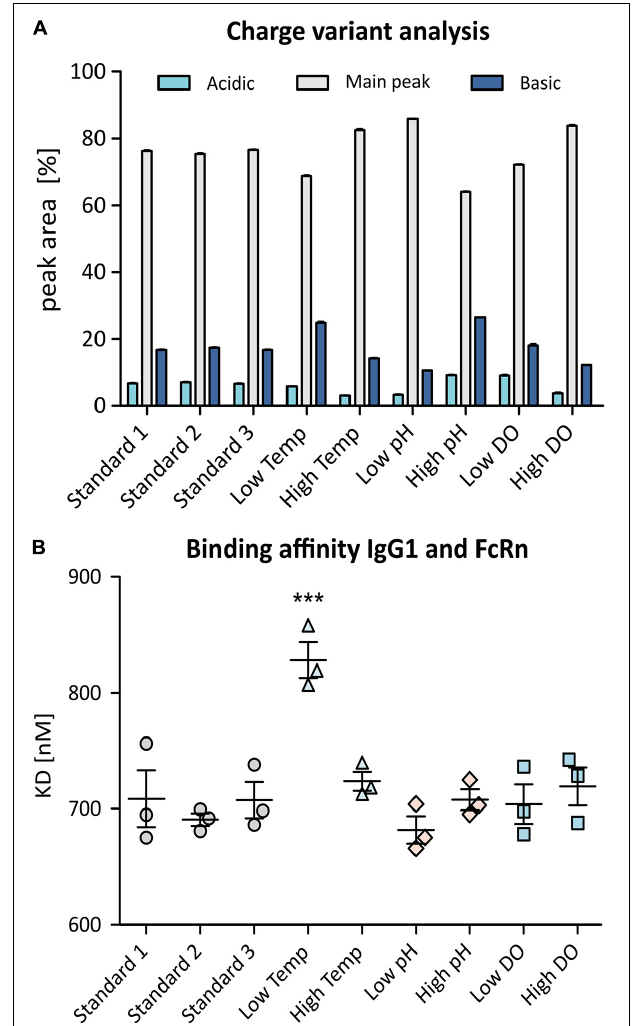
FIGURE 6 | Charge variant analysis (CVA) of produced anti-IL8 IgG1 using SCX-UV (A) . Shown are relative peak areas [%] of the main peak (gray) as well as acidic variants (light blue) and basic variants (dark blue). SPR analysis was used to determine binding affinity of the mAb to recombinant human FcRn (B) . Samples were analyzed in triplicates. Shown are measured dissociation constants (KD). Significance was determined using an ANOVA with a Tukey’s post-test (*** p ≤